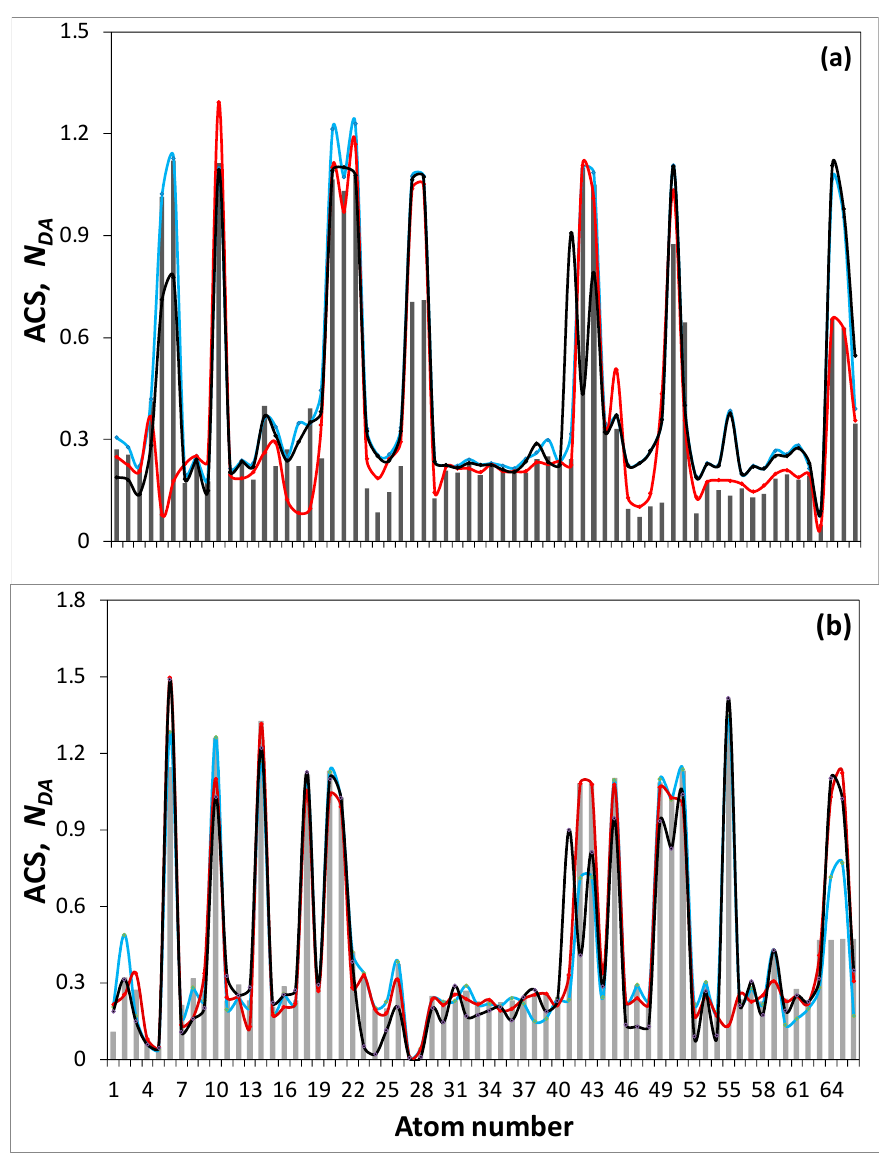
Figure 6. ACS N DA distribution over carbon atoms of the C 66 O 4 H 6 ( a ) and C 66 O 4 H 6 ( b ) before (histograms) and after (curves) decoration by single N atoms (light blue curves) and additionally by single S atoms in the circumference (red curves) and basal plane (black Figure 6.